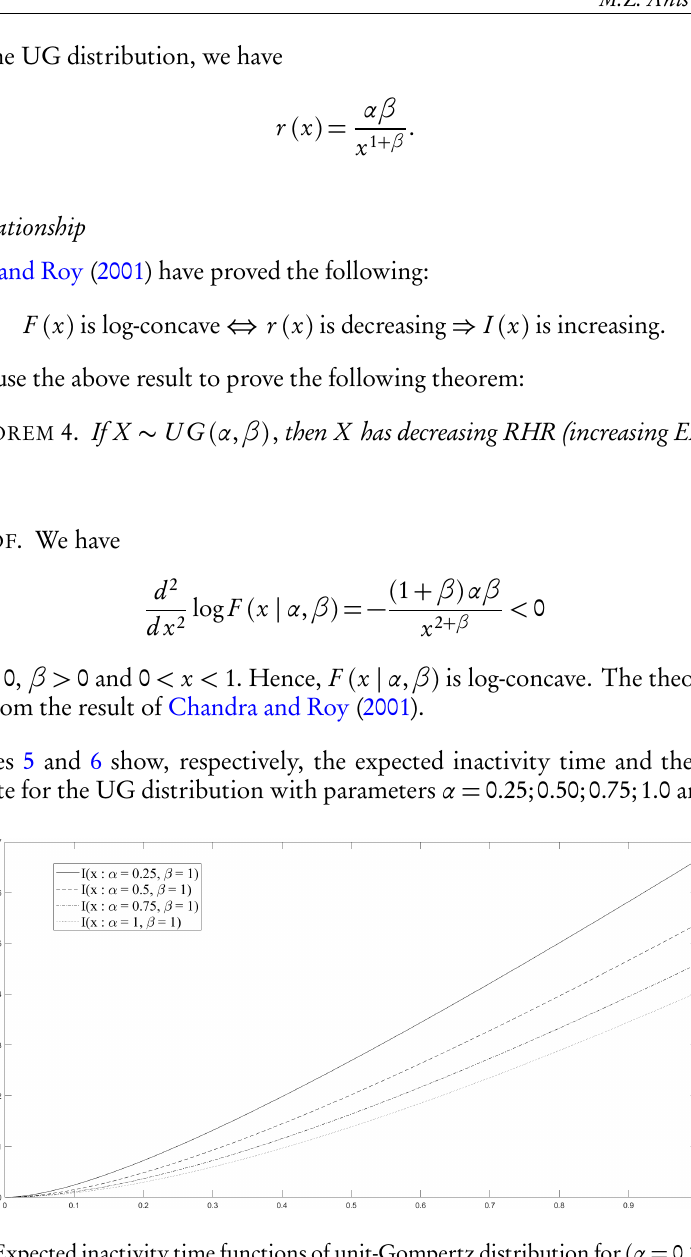
Figure 5 – Expected inactivity time functions of unit-Gompertz distribution for ( α = 0.25, β = 1 ) , ( α = 0.50, β = 1 ) , ( α = 0.75, β = 1 ) & ( α = 1, β = 1 )